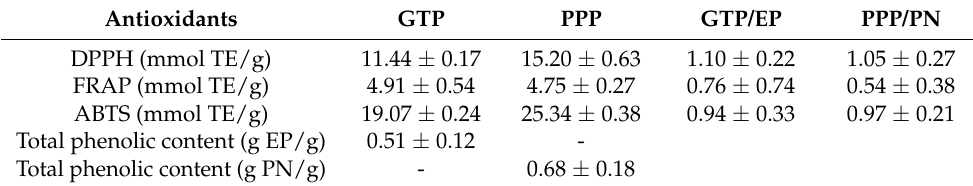
Table 1. Antioxidant capacities (ABTS, DPPH and FRAP), total phenolic contents. Antioxidants GTP